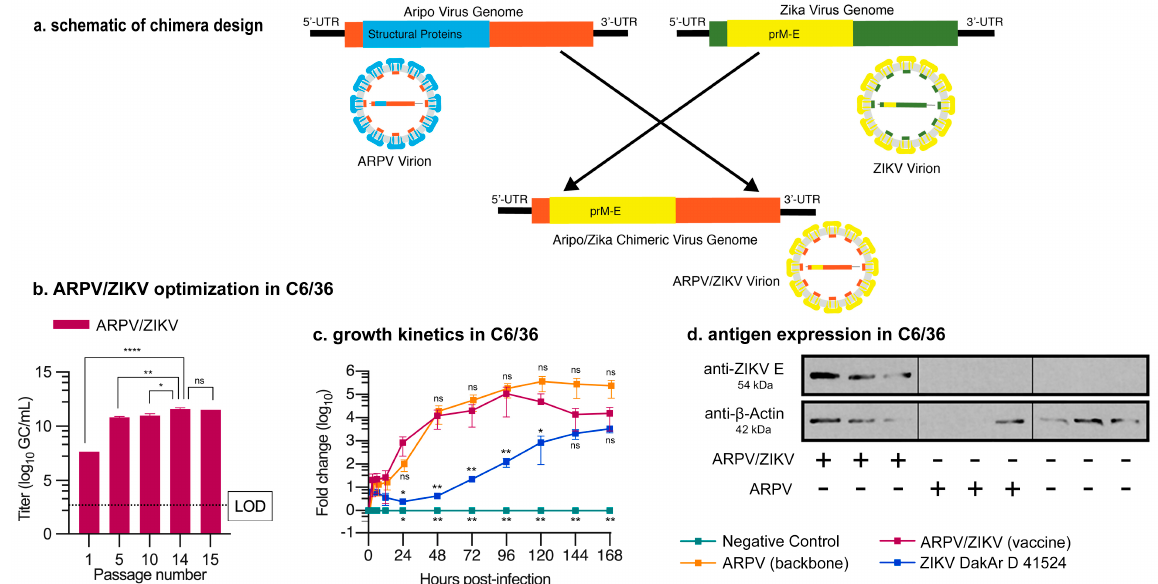
Figure 1. ARPV/ZIKV chimeric virus design and characterization. ( a ) Schematic of the chimeric ARPV/ZIKV vaccine genome. ARPV prM and E genes (blue) were replaced with ZIKV prM and E genes (yellow). The resultant chimeric virion expresses the structural ZIKV prM and E proteins (yellow), although the remaining ARPV genome (orange) is incompatible with replication in vertebrate cells. ( b ) Serial passaging of ARPV/ZIKV in mosquito cells (C6/36) facilitated enhanced growth for vaccine production, averaging 4.0 × 10 11 genome copies (GC)/mL estimated by passage 14. All titers were quantified by RT-qPCR. ( c ) Growth kinetics of ARPV/ZIKV in C6/36 cells were assessed by RT-qPCR for multiple time points over 7 days. Fold change of titers normalized to the 0 h timepoint are displayed. Absolute titers are shown in Figure S1. ( d ) ARPV/ZIKV showed stable production of desired ZIKV E antigen in mosquito (C6/36) cell cultures. C6/36 cell cultures infected with various agents (absence or presence indicated by +/ − ) were analyzed by Western blot. Membranes were probed for ZIKV E protein or a β -actin loading control (30 s and 15 min exposure on autoradiography film, respectively). ARPV E protein showed no cross-reactivity with commercial anti-ZIKV E antibody. Linear adjustments to brightness and contrast were applied across the entire image for clarity. Radiograph images were spliced together for labelling purposes. Whole membranes are shown in Figure S2. A log 10 transformation was applied before analysis via a one-way ANOVA and ad hoc Tukey’s test ( b ) or two-way ANOVA with Geisser–Greenhouse correction and Dunnett’s test ( c ). Error bars indicate SD of the mean. Asterisks indicate significance compared to ARPV/ZIKV: not significant (ns), p ≤ 0.033 (*), p ≤ 0.002 (**), and p ≤ 0.0001 (****).